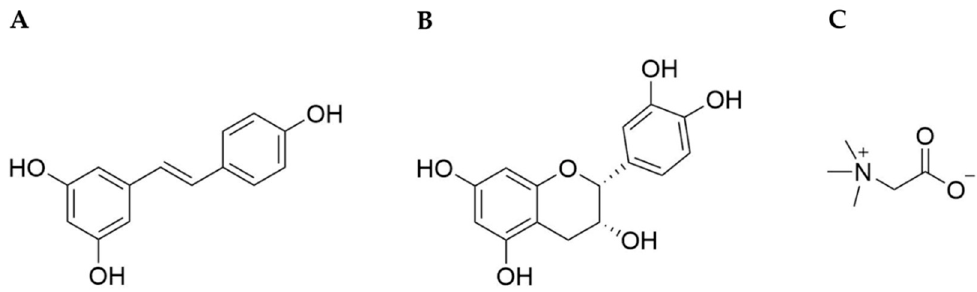
Figure 1. Chemical structures of resveratrol ( A ), (–)–epicatechin ( B ), and betaine ( C ).